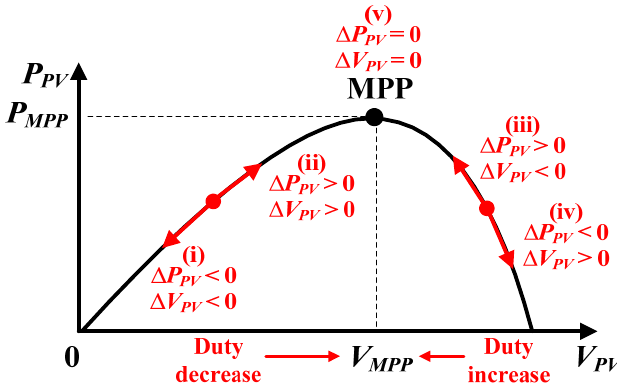
Figure 2. Principle of operation for the hill-climbing and perturb and observe (P&O) algorithms. Table 1. Methodology of the hill-climbing and P&O algorithms.